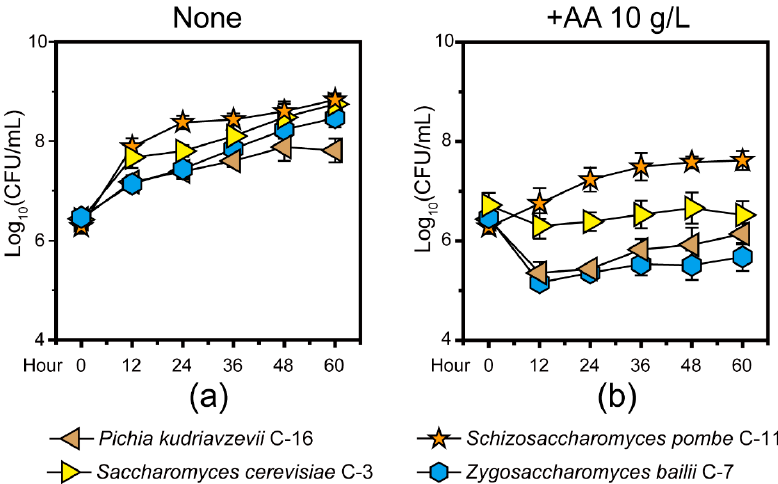
Figure 1. The microbial biomass of four core yeast strains ( Pichia kudriavzevii C-16, Saccharomyces cerevisiae C-3, Schizosaccharomyces pombe C-11, and Zygosaccharomyces bailii C-7) isolated from fermentation microbiota in None ( a ) and +AA 10 g/L ( b ) group samples (see details in Section 2). Data are expressed as mean ± SD from biological triplicates. Error bars indicate standard deviation from three independent experiments.